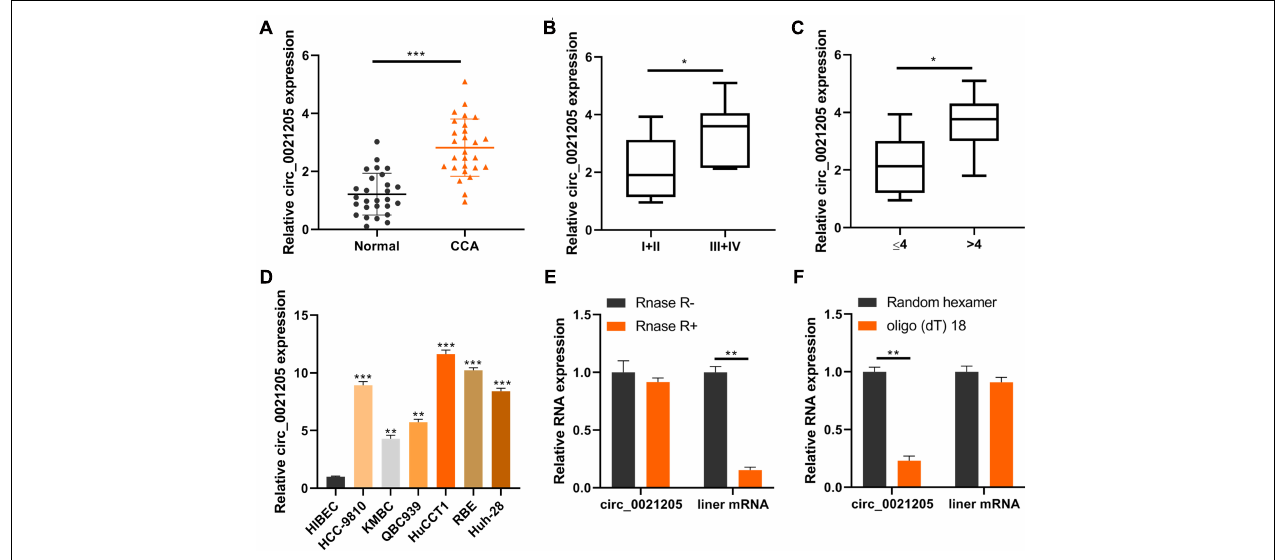
FIGURE 1 | Circ_0021205 is upregulated in CCA. (A) QRT-PCR data showed that circ_0021205 was significantly upregulated in CCA tissues than controls. (B,C) QRT-PCR data showed that circ_0021205 expression in ≥ 4 cm size or I + II stage tumor tissues was higher than in small size or III + IV stage tumors. (D) The relative expression of circ_0021205 in different cell lines was detected using qRT-PCR. (E) QRT-PCR data showed that circ_0021205 expression has not been decreased after RNase R treatment. (F) QRT-PCR data showed that circ_0021205 could not be amplified by oligo(dt) 18 primers. All experiments were repeated at